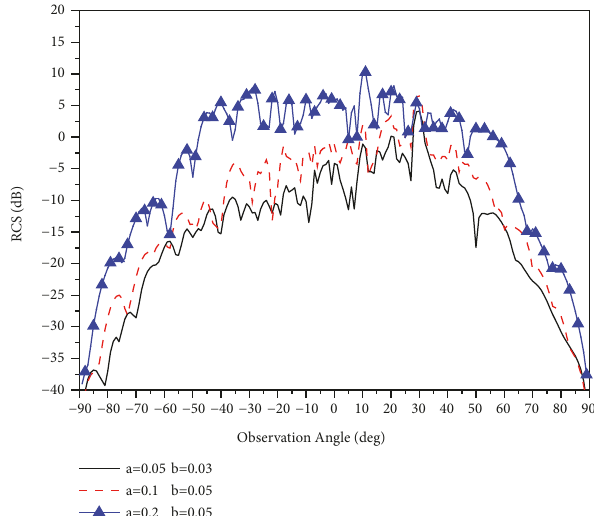
Figure 10: RCS with different shapes of